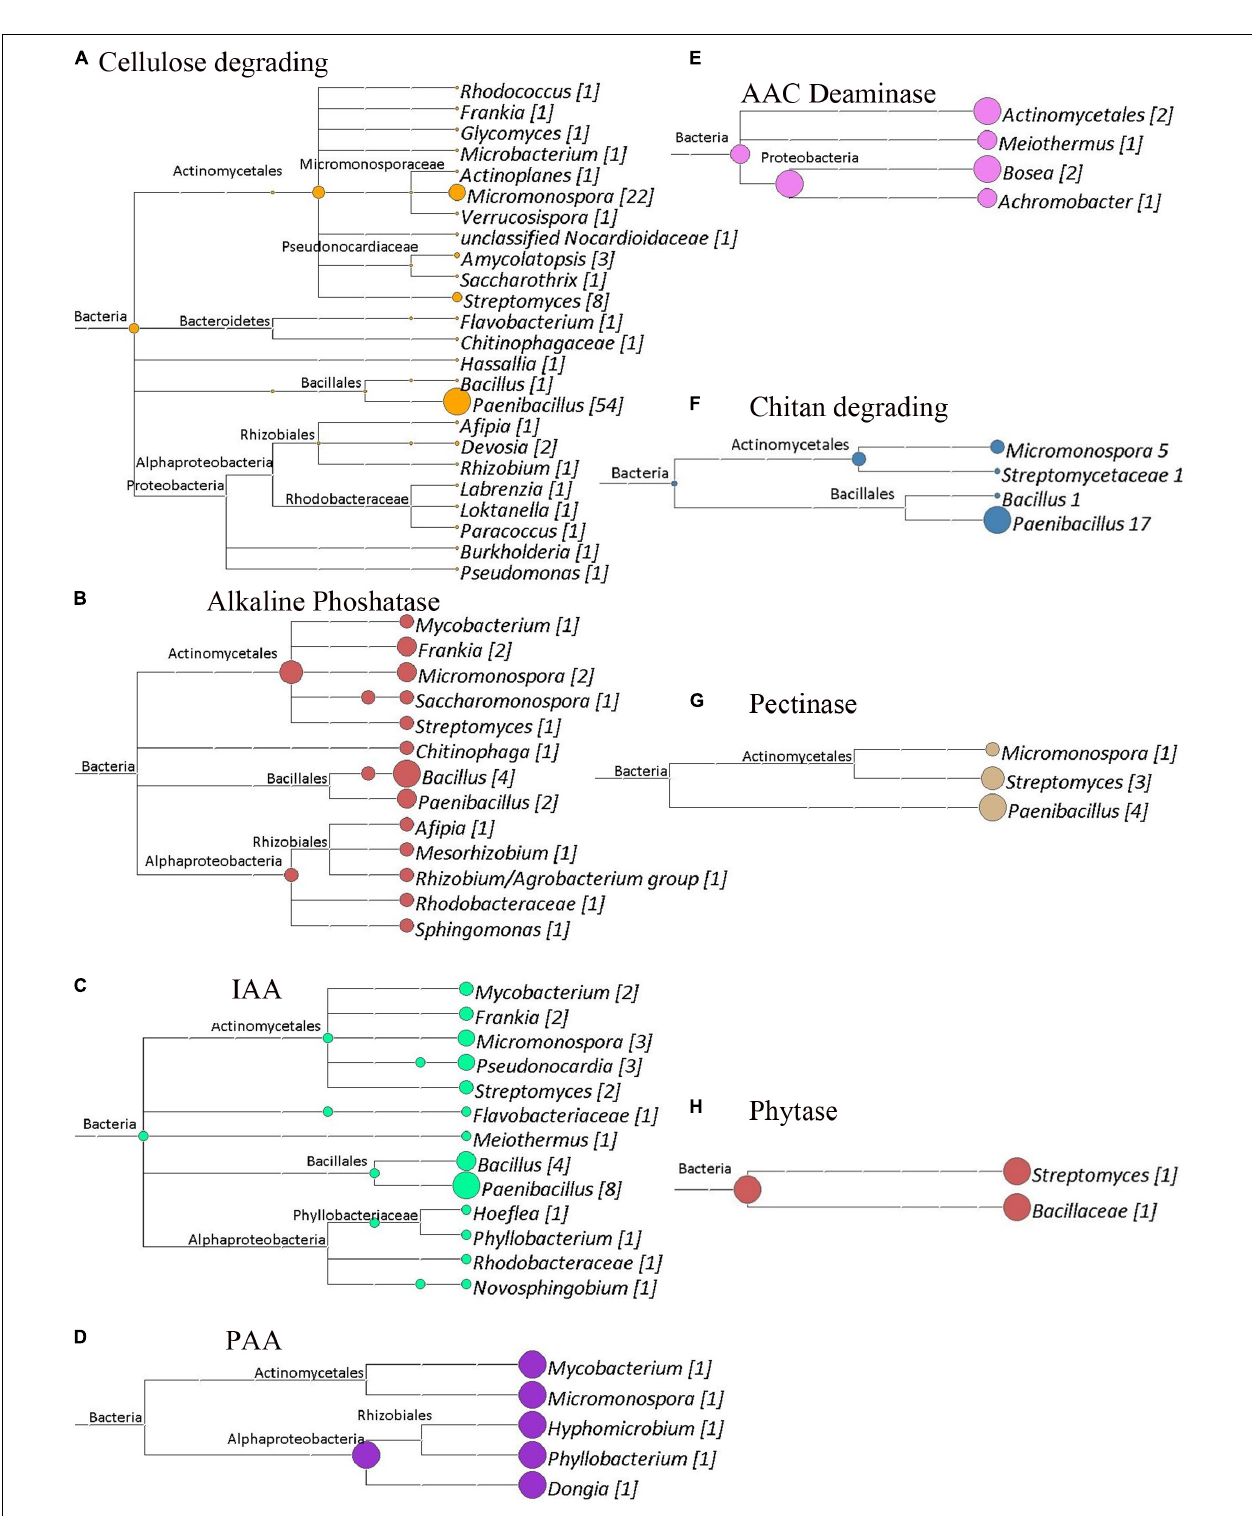
FIGURE 9 | Cladograms of functional genes from Site 3 (Medenine), that were produced by the LCA Algorithm in MEGAN (Version 5). The sizes of colored circles represent that relative contribution of a taxa to the functional genes analyzed in a given cladogram. Numbers in Brackets represent that actual number of genes that annotated to a given taxon for that set of genes. (A) Cellulose degrading genes. Total genes identified, 108. (B) Alkaline phosphatase genes. Total genes identified, 19. (C) Potential indole acetic acid biosynthetic genes. Total genes identified, 30. (D) Potential phenyl acetic acid biosynthesis genes. Total genes identified, 5. (E) ACC deaminase genes. Total genes identified, 6. (F) Chitin degrading genes. Total genes identified, 24. (G) Pectinase genes. Total genes identified, 8. (H) Phytase genes. Total genes identified, 2.